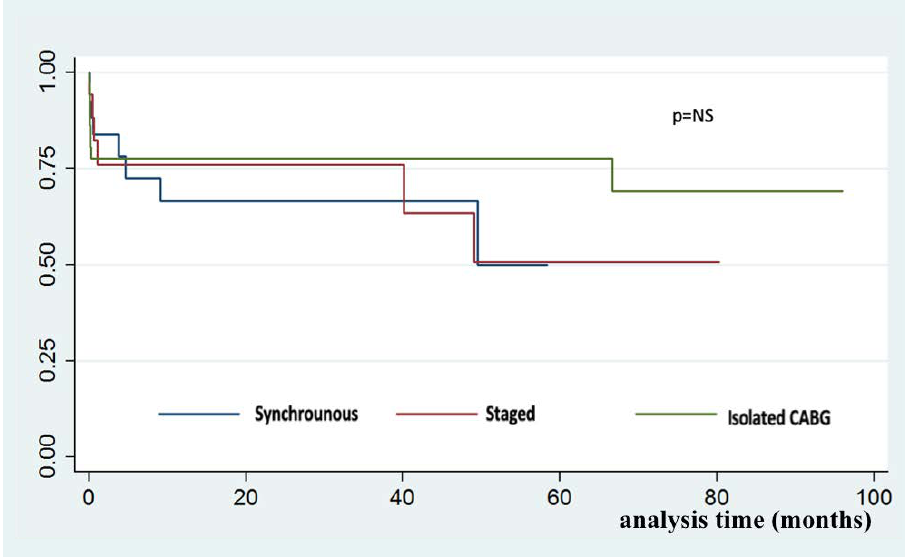
Fig. 1 - Discloses the Kaplan-Meier survival curves during the median of 2.05 years of follow-up according to surgical treatments. CABG=coronary artery bypass